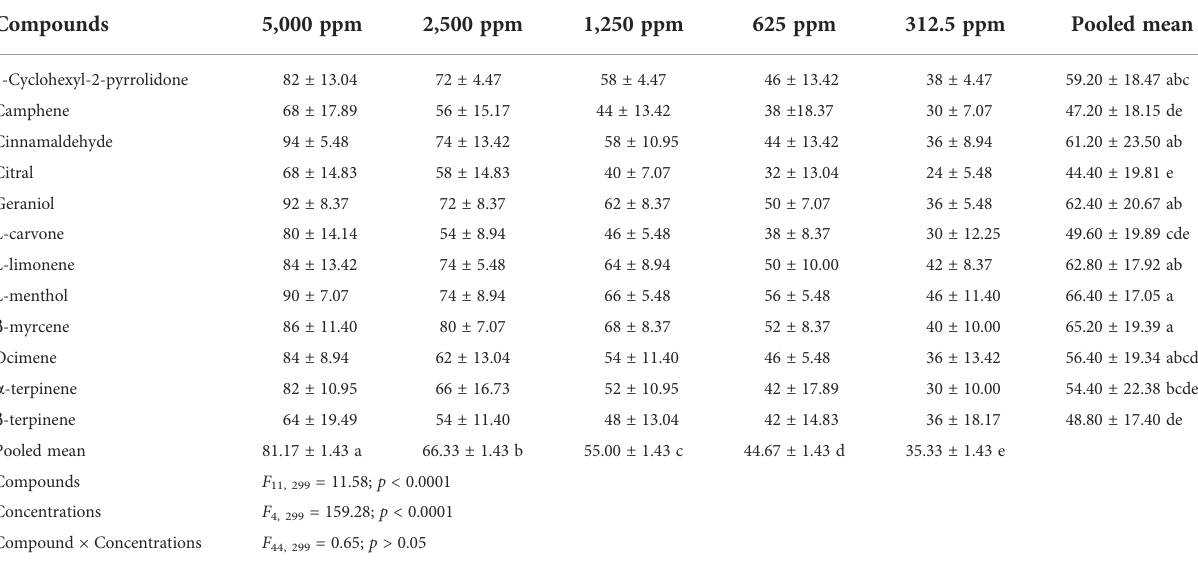
TABLE 5 Toxicity effect of various compounds against the second instar crawlers of P. lilacinus . Percent mortality (mean ± SE) at different concentrations after 72 h Compounds